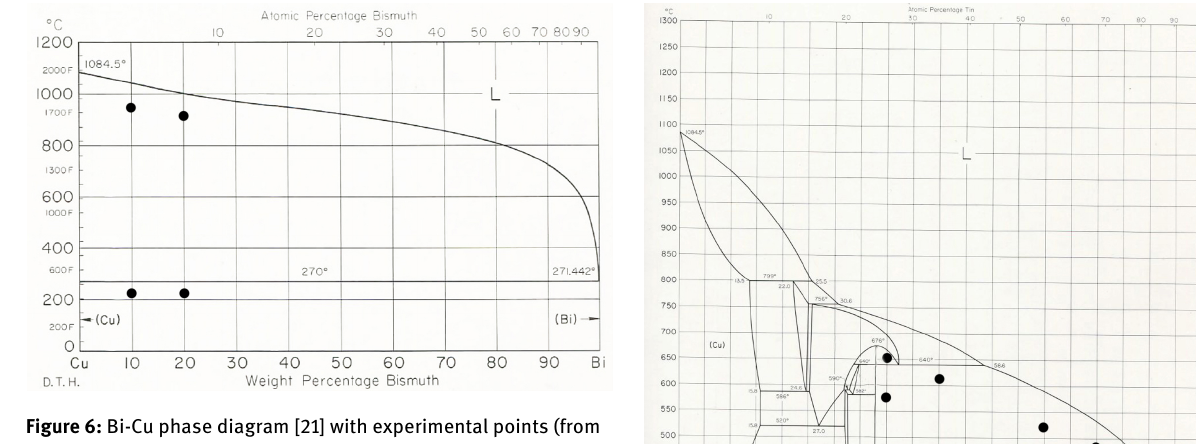
Figure 6: Bi-Cu phase diagram [21] with experimental points (from the left) 1 and 2, Table 1.